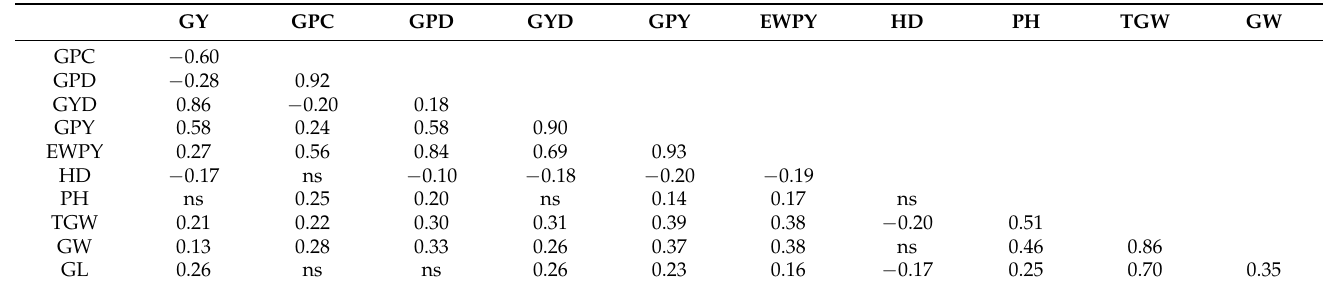
Table 2. Phenotypic correlations of the BMWpop across environments.